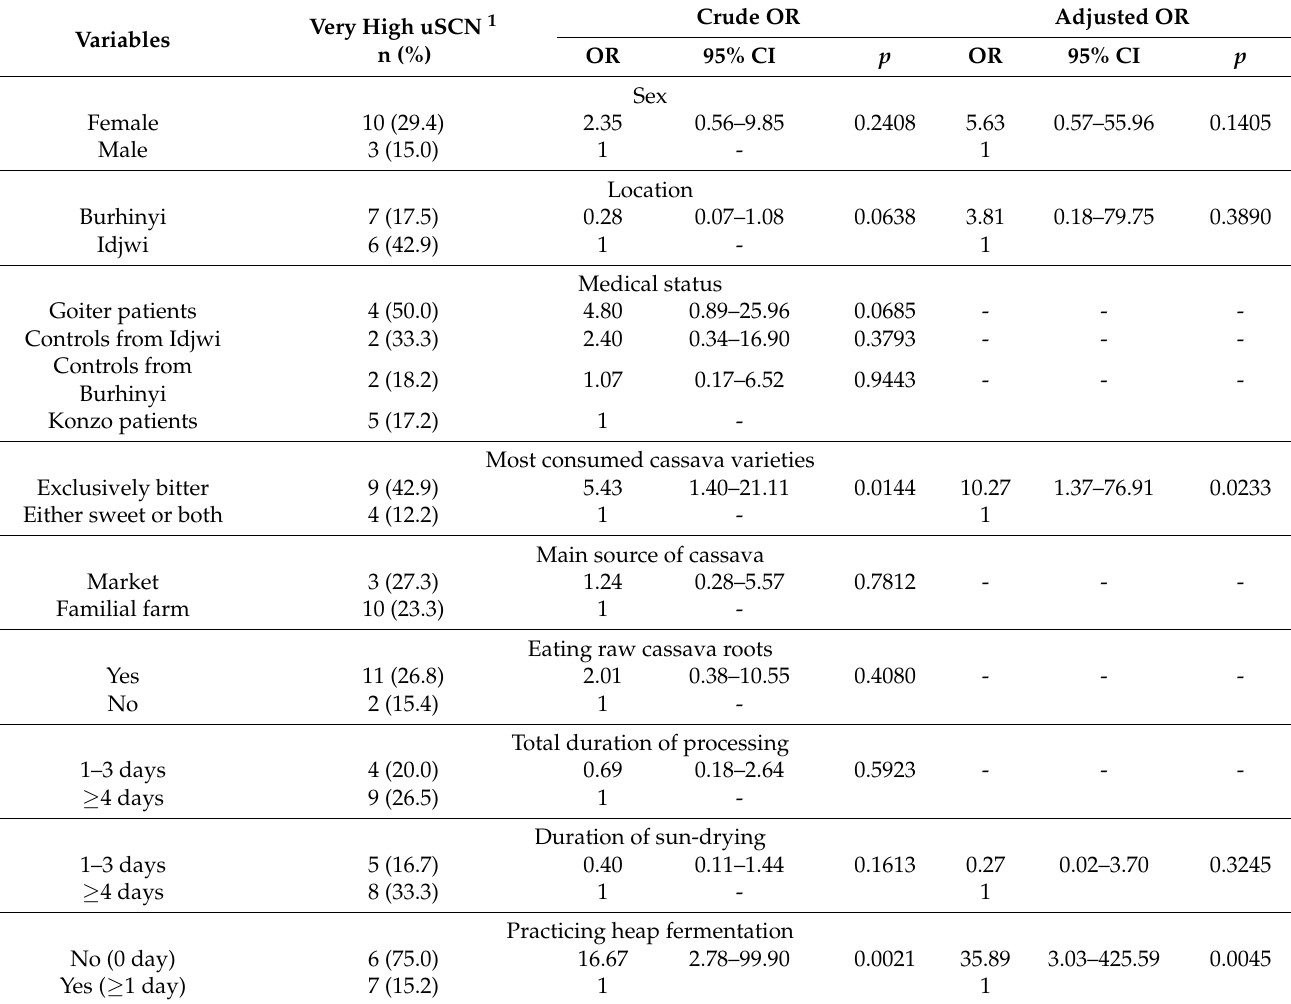
Table 5. Factors associated with very high urinary thiocyanate levels during the dry